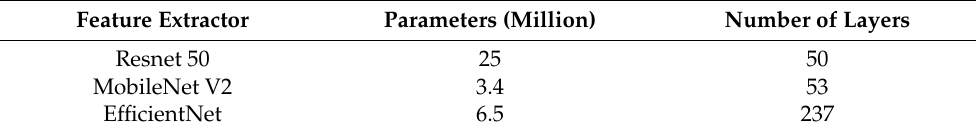
Table 2. Properties of the selected feature extractor.